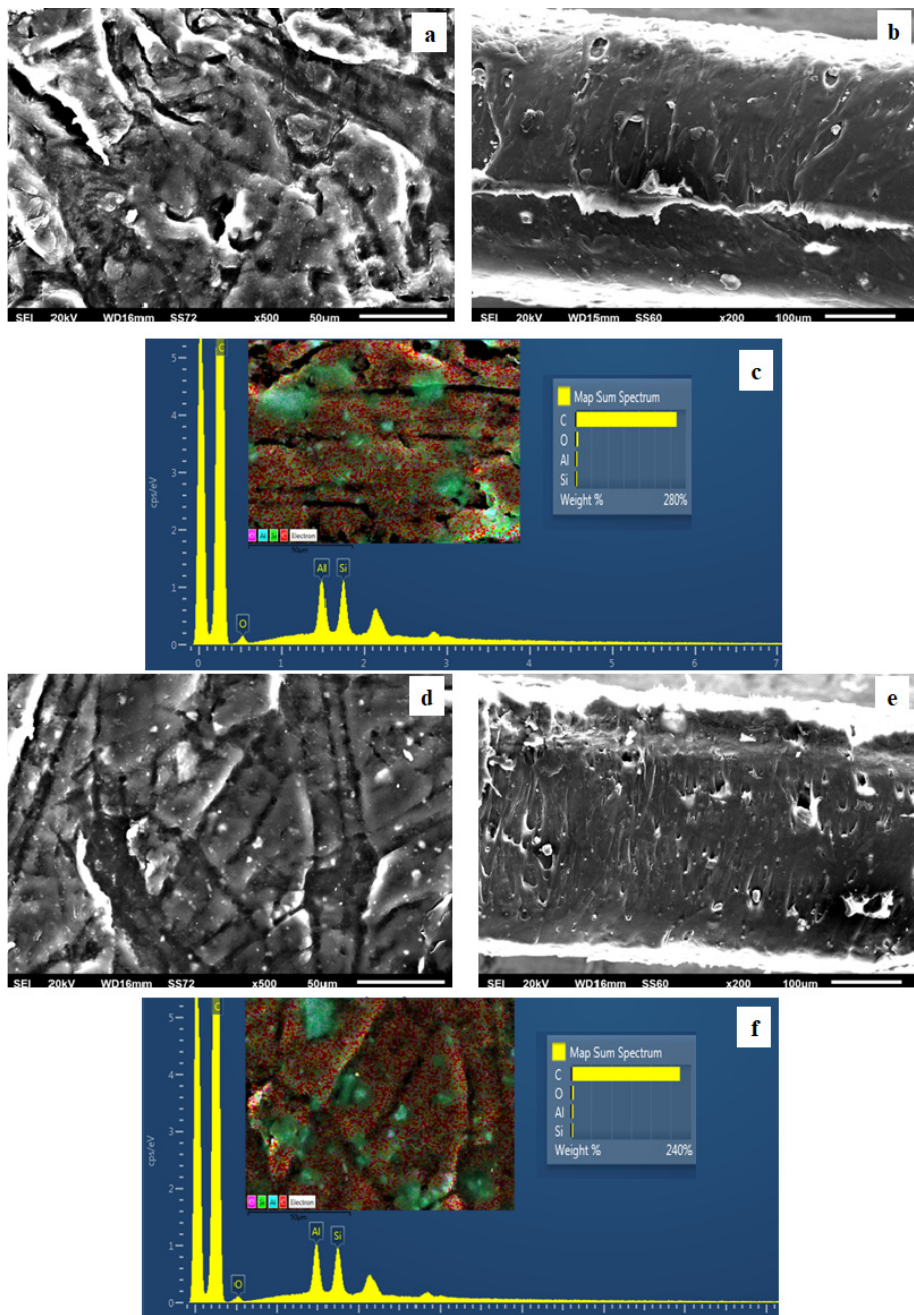
Figure 7. ( a , d ) SEM images of surface and ( b , e ) cross-section for the nanocomposite films of LDPE/15HNT ( a , b ) and LDPE/15TO@HNT ( d , e ), respectively. ( c , f ) Energy dispersive spectrometer (EDS) spectra, relative elemental analysis, and mapping of the surface from the SEM images at x1000 magnification.